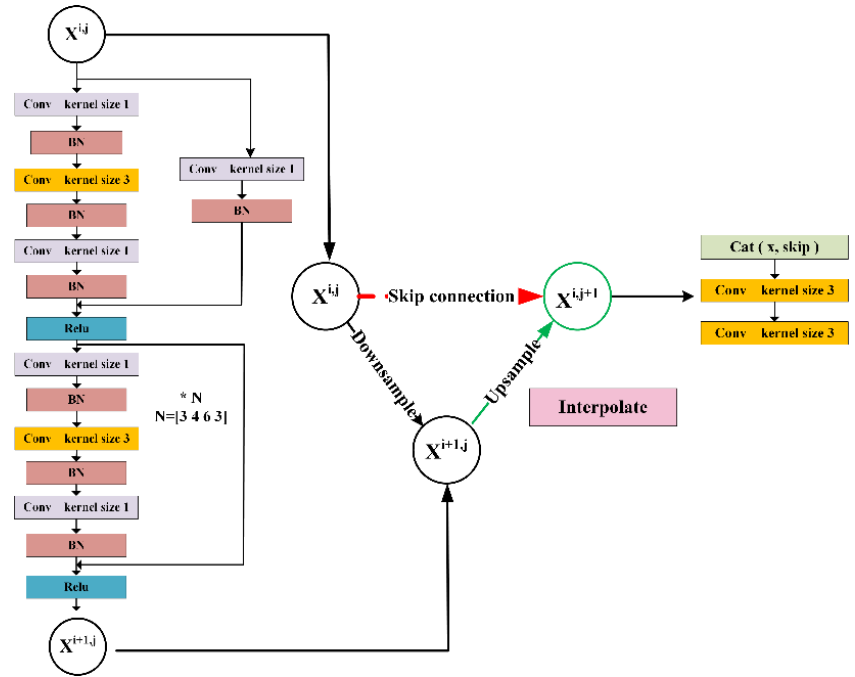
Figure 6. The detailed structure in U − Net++. It represents the process in U − Net++ with the feature maps X i, j , X i+1, j, and X i, j+1 . The left part is the structure of ResNet50; *N represents the cycles of blocks in each stage, which is [3, 4, 6, 3].